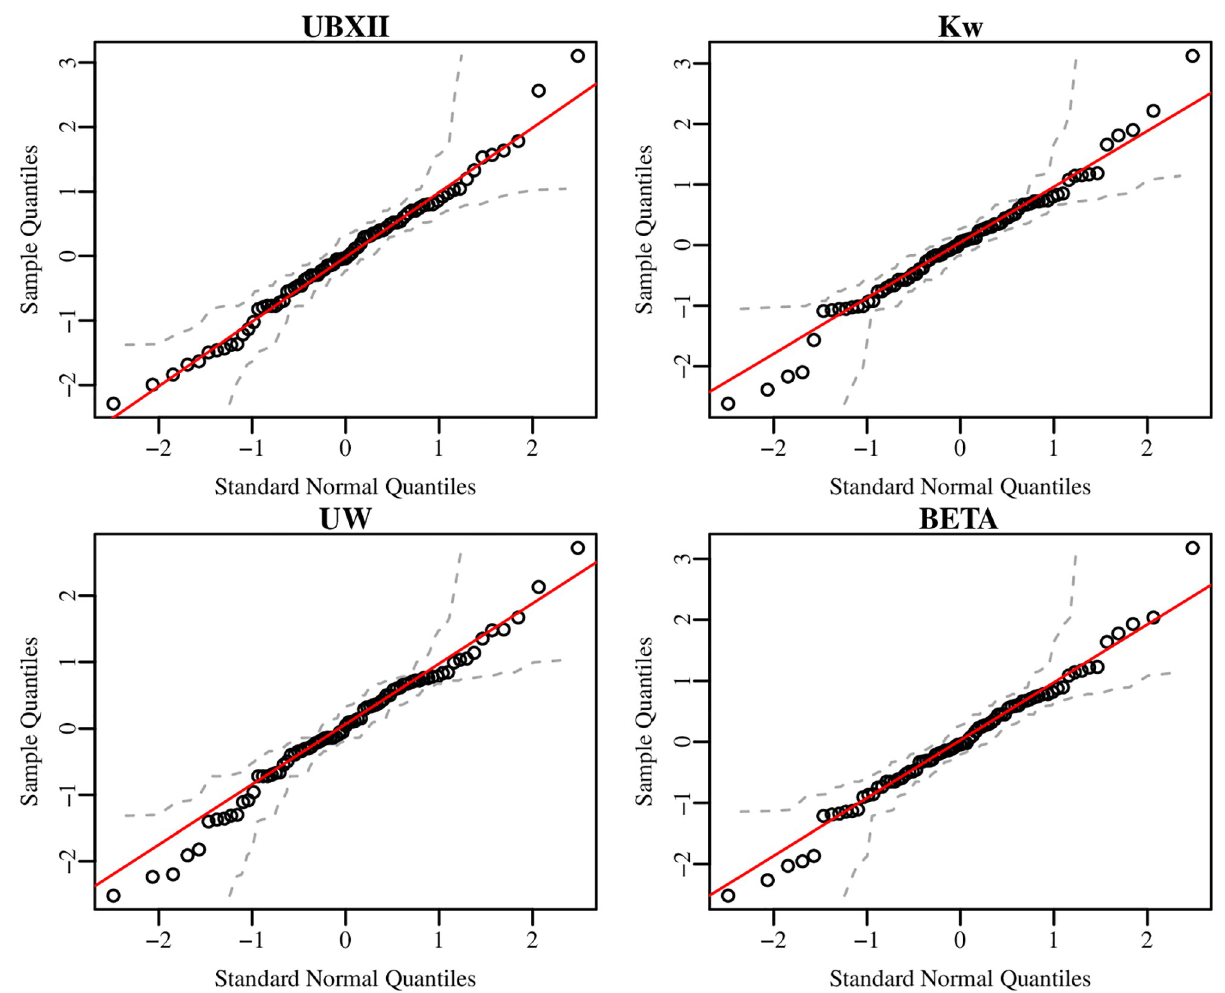
Fig 7. QQ-plots of the UBXII, Kw, UW, and beta regressions’ residuals.